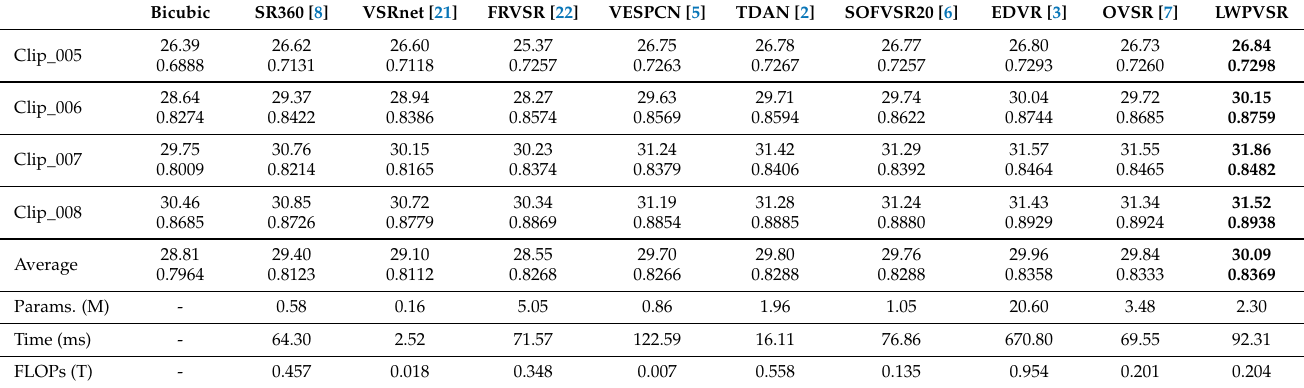
Table 2. Comparison of all the methods in terms of WS-PSNR (top) and WS-SSIM